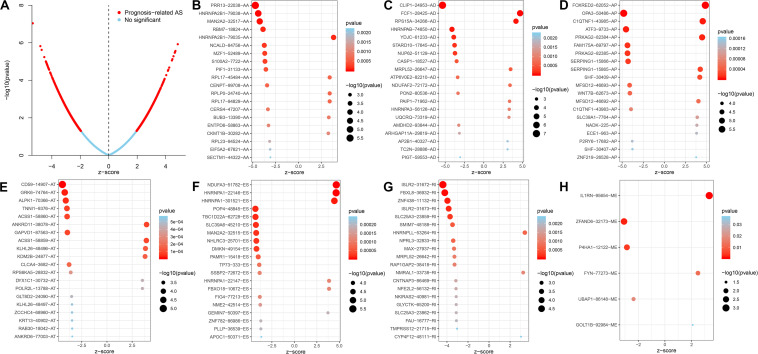
Top 20 of significant prognosis related AS events in the CC cohort. (A) Red dots indicate survival-related AS events in CC. Blue dots indicate AS events unrelated to survival in CC. (B–H) Bubble plots of the top 20 survival associated AA, AD, AP, AT, and RI events in CC, respectively.